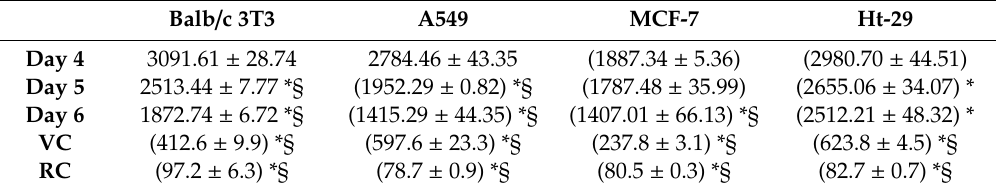
Table 2. Summary of the resazurin data of each cell line versus the target days at post-confluence. Balb / c 3T3 A549